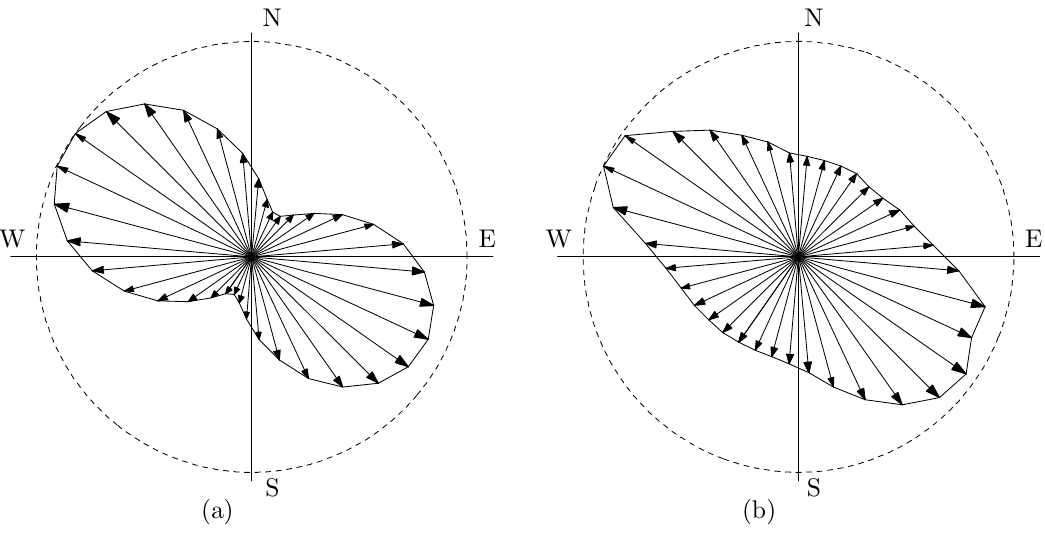
FIG. 15: Total kinetic energy computed three days after the wind set-up (steady state) subject to constant wind from different directions with the vertical eddy viscosity ν v = 0 . 02 m 2 s − 1 . The computations are performed for two cases: (a) the Coriolis effect is considered; (b) the Coriolis force is neglected. The directions of the drawn arrows are the wind directions (for an interval of 10 ◦ ) around the basin, their lengths indicate the magnitudes of the total kinetic energy. The dashed circles show the maximum value of the total kinetic energy in all directions, which is 1 . 11 × 10 10 Nm for (a), but 4 . 65 × 10 10 Nm for (b).